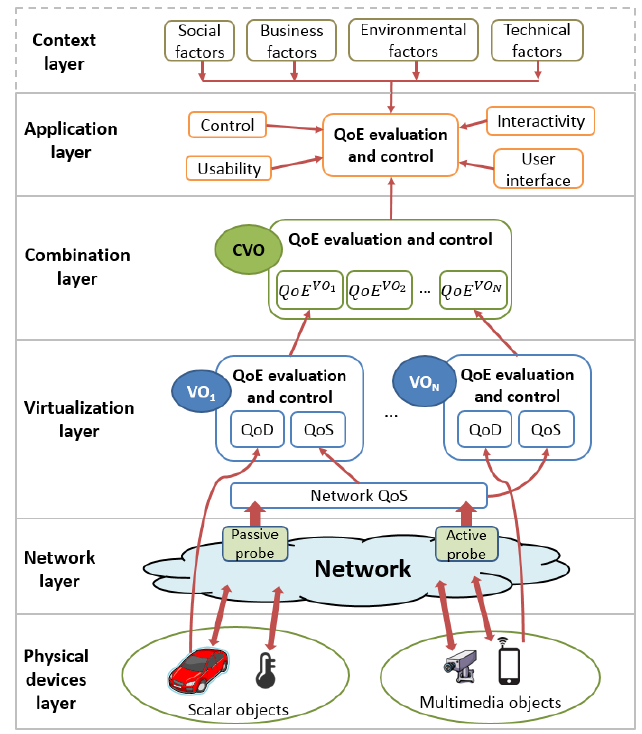
Figure 4. The proposed layered Quality of Experience (QoE) management